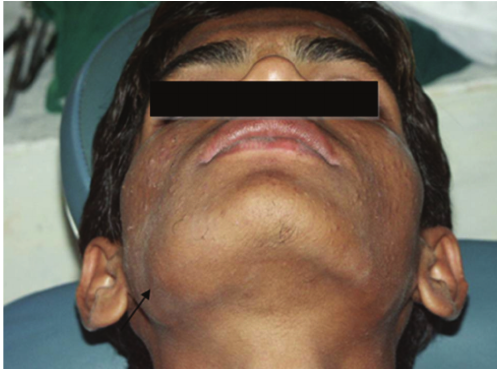
Figure 1: Extraoral photograph, showing swelling in the right-side mandibular body.